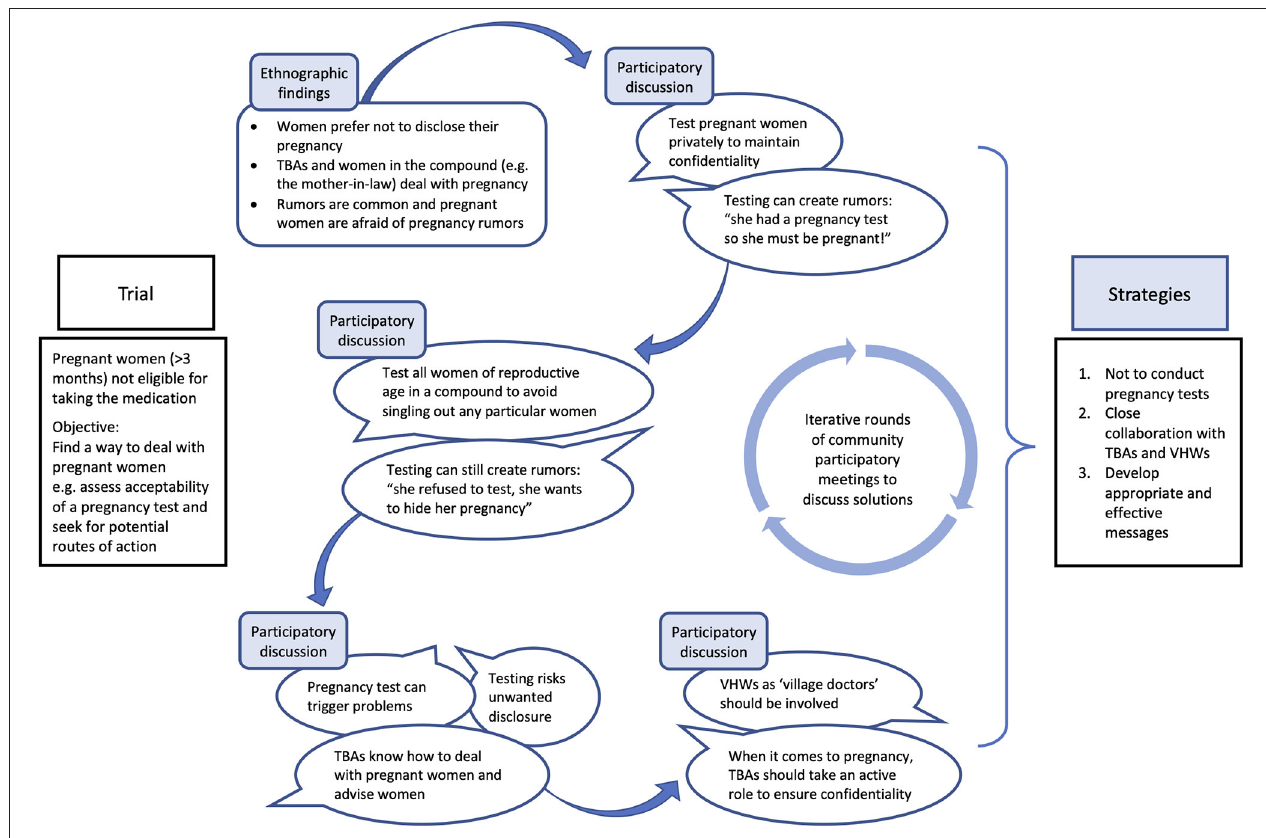
FIGURE 4 | Example: co-development of strategies through iterative dialogues and data